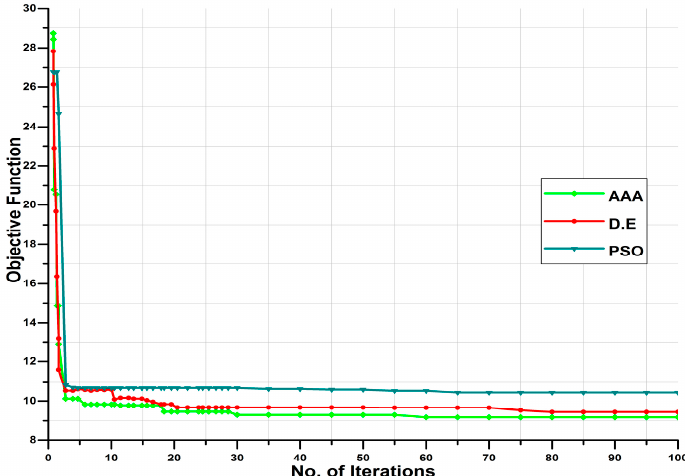
Figure 5. Power Flow distribution for Case Study-1 by AAA, D.E and PSO when line 1 is trip.